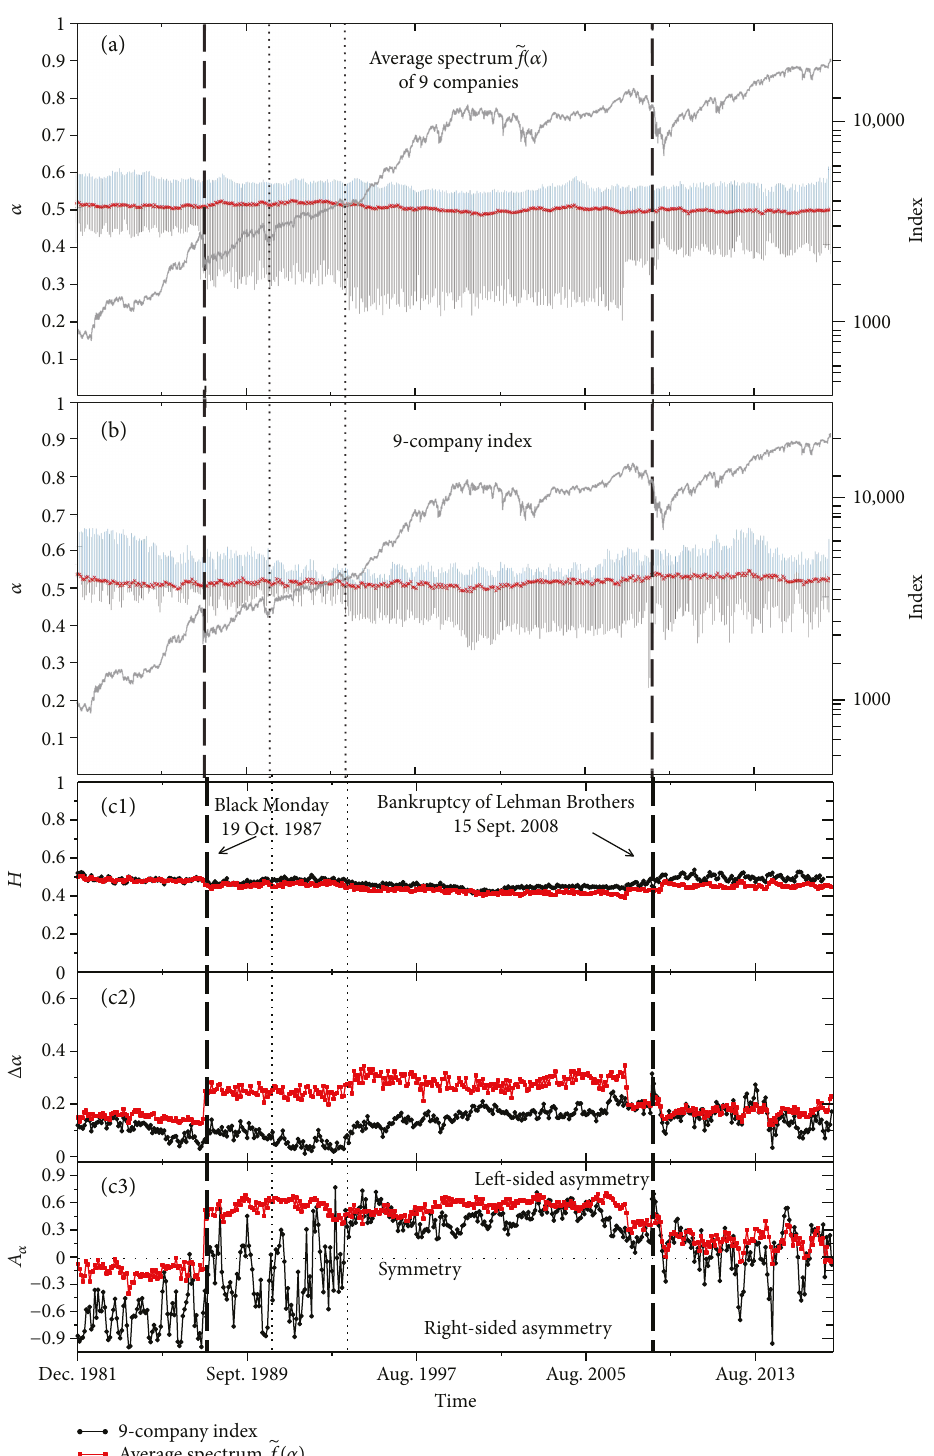
Figure 9: Projections onto the time t − α plane of the sequence of singularity spectra f α calculated within a rolling 20-year window for both the average spectrum f α (a) and (b) the arti fi cial index of the 9 companies of Figure 8. The calendar date assigned to each f α corresponds to the ending point within a window. This window is moved with the step of 20 points which corresponds to approximately one calendar month. The red line illustrates displacement of the maxima of f α in the consecutive windows. Vertical dashed lines indicate the Black Monday of October 19, 1987, and bankruptcy of the Lehman Brothers in September 15, 2008, while the dotted ones indicate October 1990 and April 1994. The bottom three panels display the corresponding Hurst exponents H (c1), widths Δα (c2), and the asymmetry coe ffi cients A α